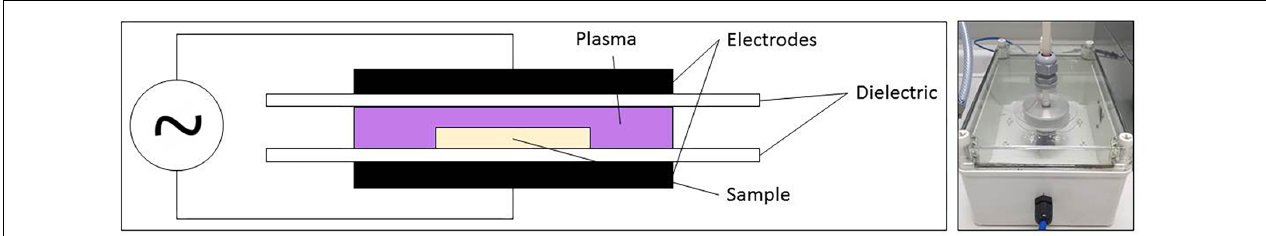
FIGURE 1 | CAP set-up for plasma activated liquid